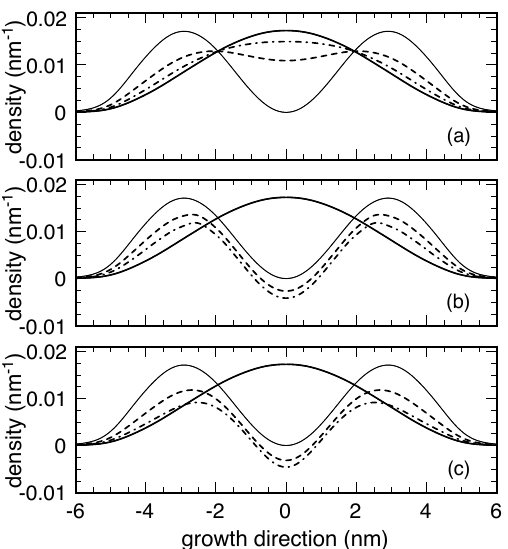
Figure 4. Low-temperature dissipation dynamics in the 12nm thick GaAs/AlGaAs QW of Figure 3. The carrier density n ( z ) in Equation (14) is plotted as a function of position at different times (0ps: thin solid curve; 0.8ps: dashed curve; and 1.6ps: dash-dotted curve) for models: M1 ( a ); M2 ( b ); and M3 ( c ). Here, the following parameters are employed: 1/ Γ 0 = 0.8ps for M1, 1/ Γ 0 = 0.4ps and a = 5nm for M2, and 1/ Γ 0 = 0.5ps and (cid:101) min = 40meV for M3. The equilibrium carrier density is also shown for comparison (solid curve). Reprinted from